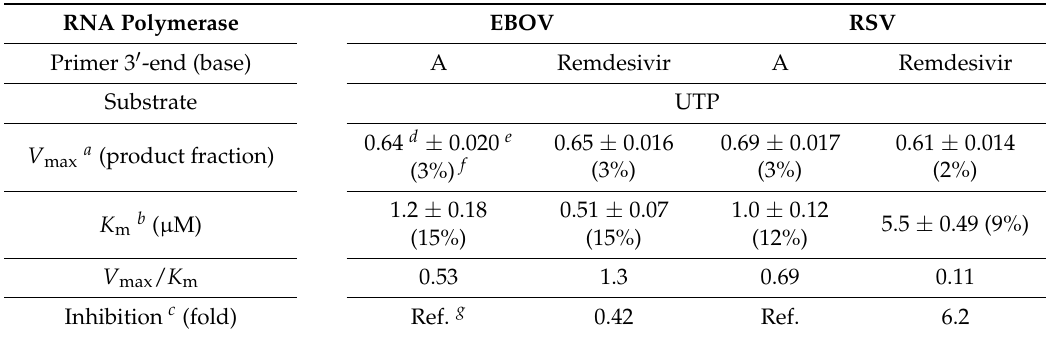
Table 2. Inhibitory effect of the incorporated remdesivir-MP on the subsequent nucleotide incorporation. RNA Polymerase